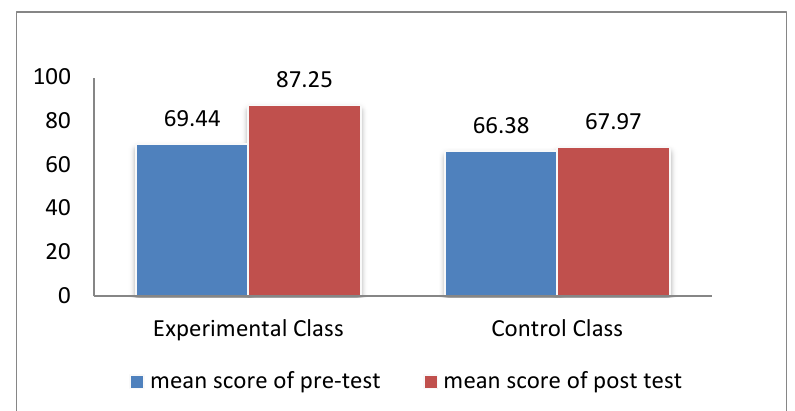
Chart 1: Comparison of Pre-test and Post-test